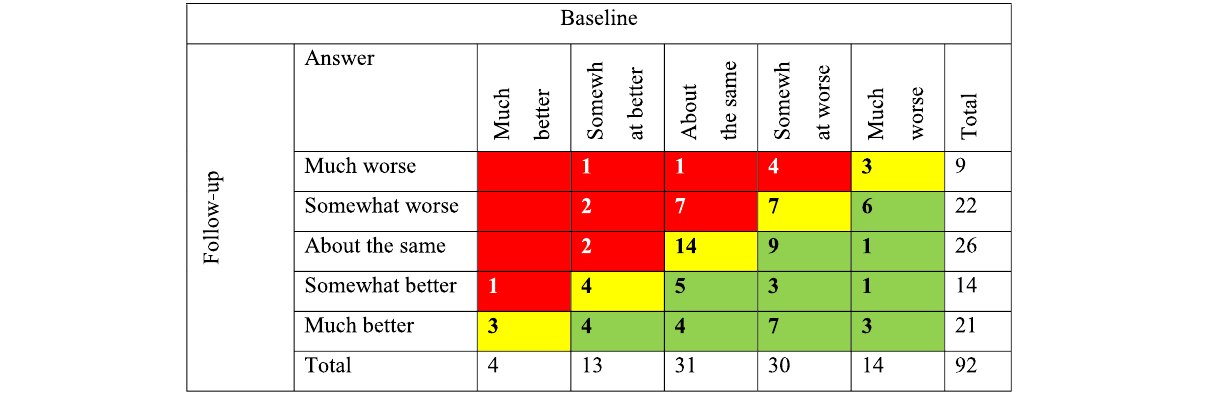
The diagonal (yellow) represents patients who answered the same at baseline and follow-up ( n =31; PA=34%), those who improved are shown below the diag- onal (green) ( n =43, 46%) and those worsened are above the diagonal (red) ( n =18,